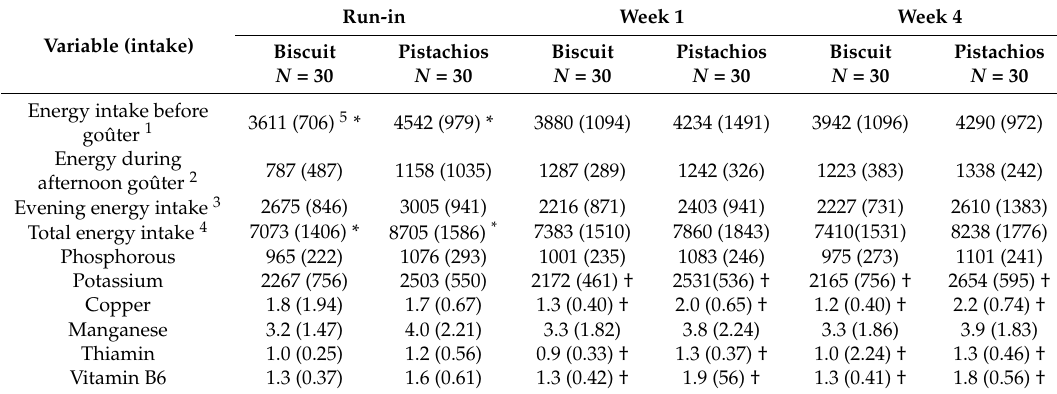
Table 3. Mean energy (kJ) and micronutrient intake (mg) throughout the